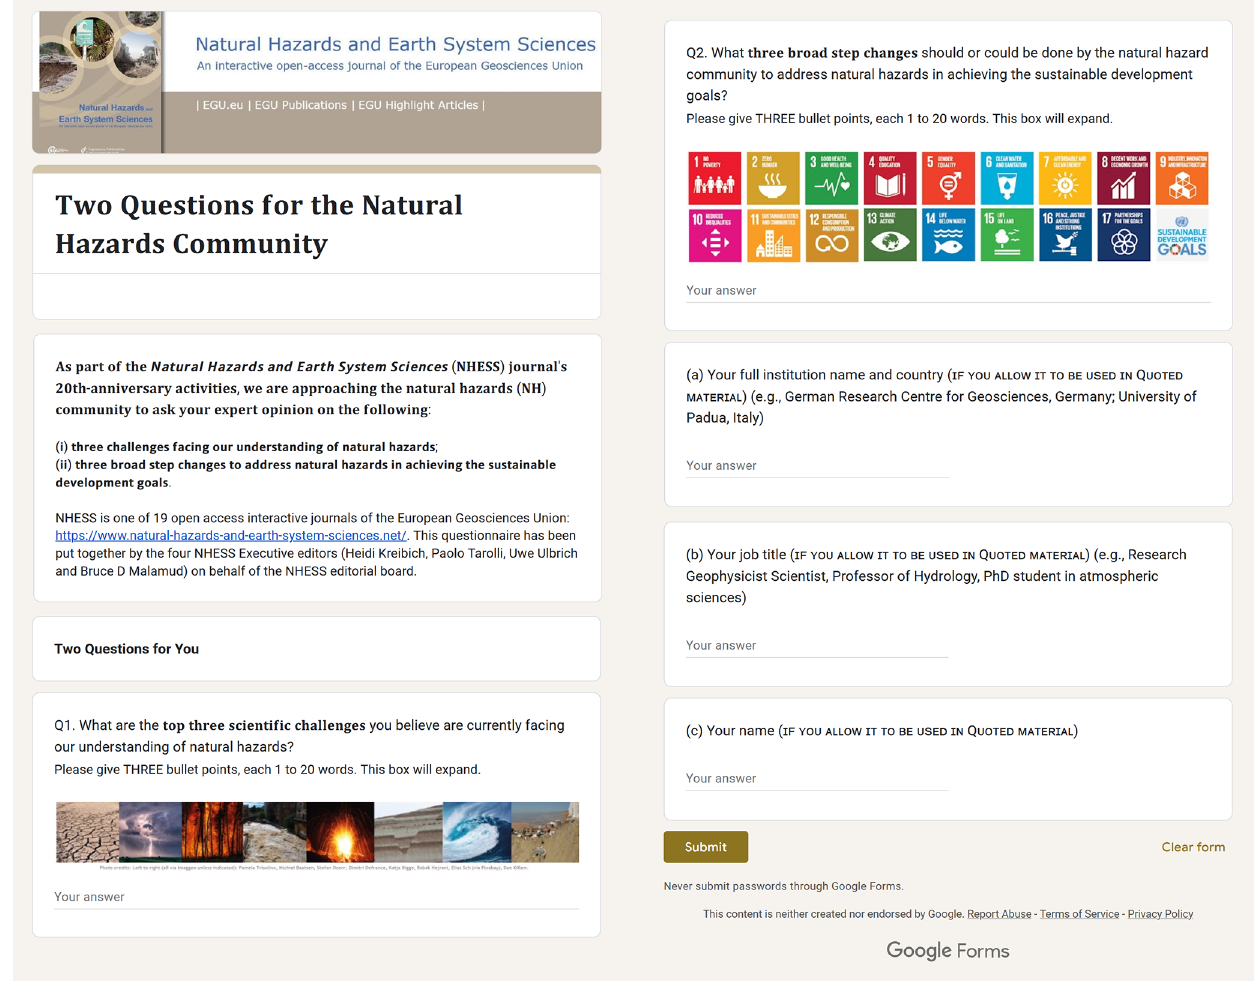
Figure A1. Online survey form for the NHESS 20th anniversary questionnaire in Google Forms to which 350 natural hazard community members